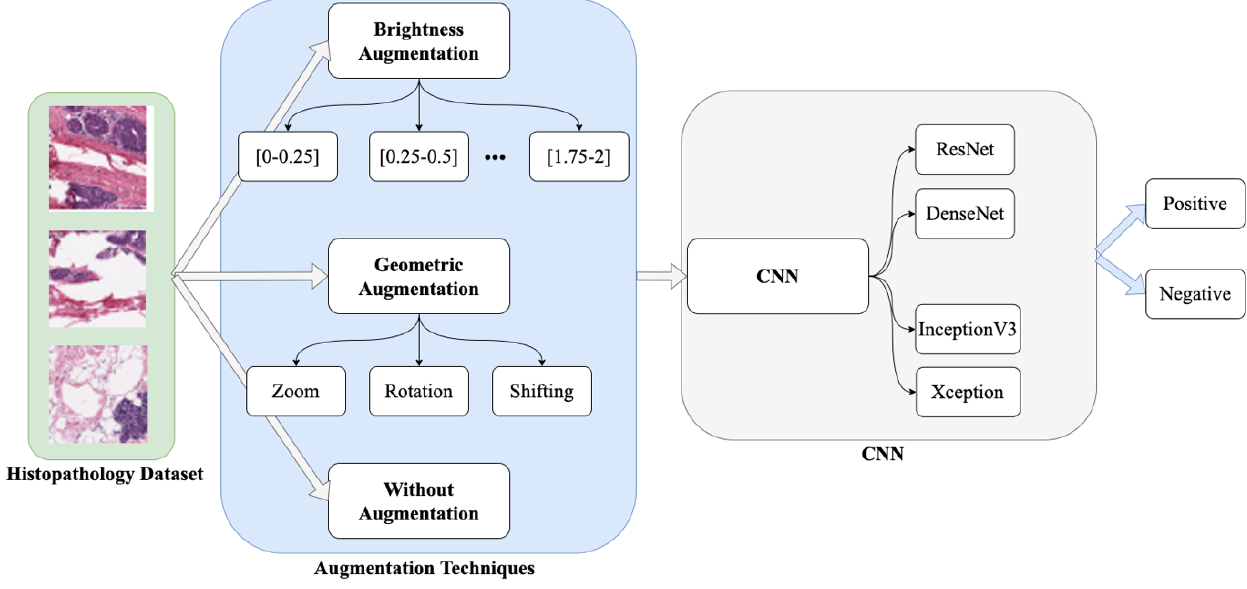
Figure 4. Flowchart of the experiments executed in this